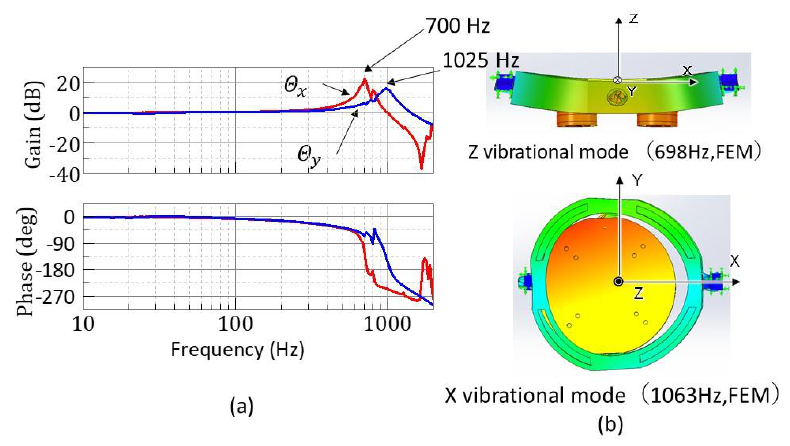
Figure 14. Reference characteristic of the FSM using gimbal mechanism: ( a ) Bode plots in the θ x and θ y directions; ( b ) simulated vibration modes near the peak frequencies.